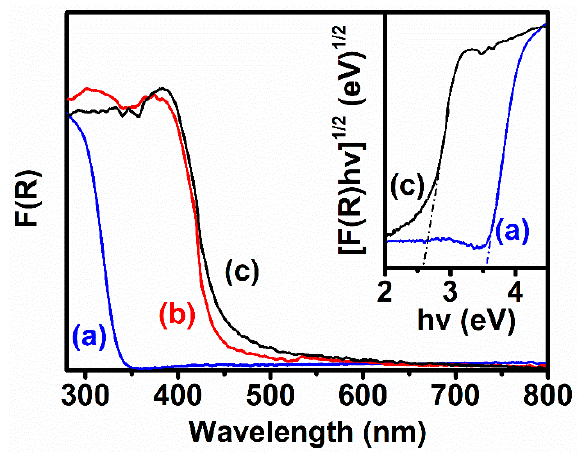
Figure 4. UV-VIS absorption spectra of the as-synthesized samples: (a) PW 9 ; (b) PW 9 / g-C 3 N 4 heterojunction NSs; (c) g-C 3 N 4 NSs; the inset were plots of the [F(R)(h υ )] 1 / 2 versus h υ of (a) PW 9 ; (c) g-C 3 N 4 NSs.